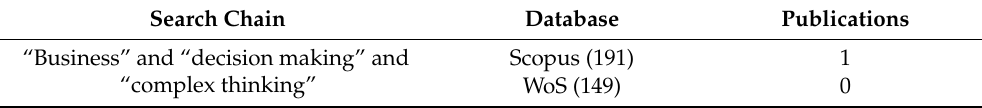
Table 4. Articles linking business decision-making and complex thinking.